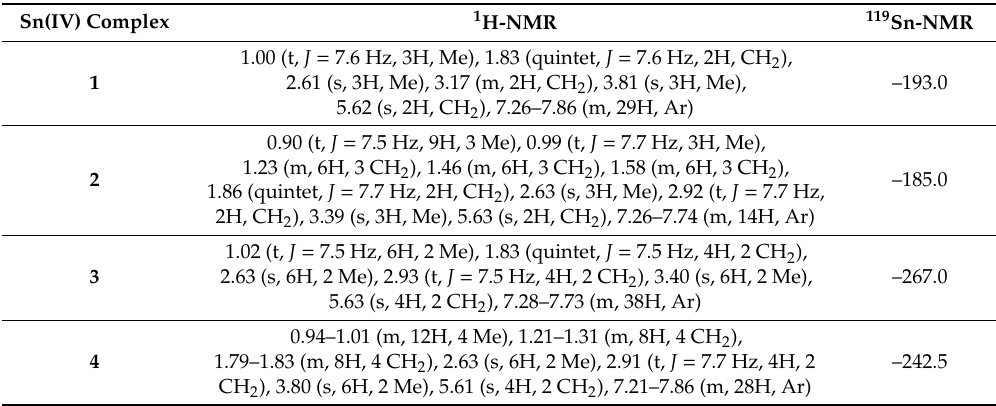
Table 3. 1 H- and 119 Sn-NMR spectral data (ppm, DMSO- d 6 ) of complexes 1 – 4 .